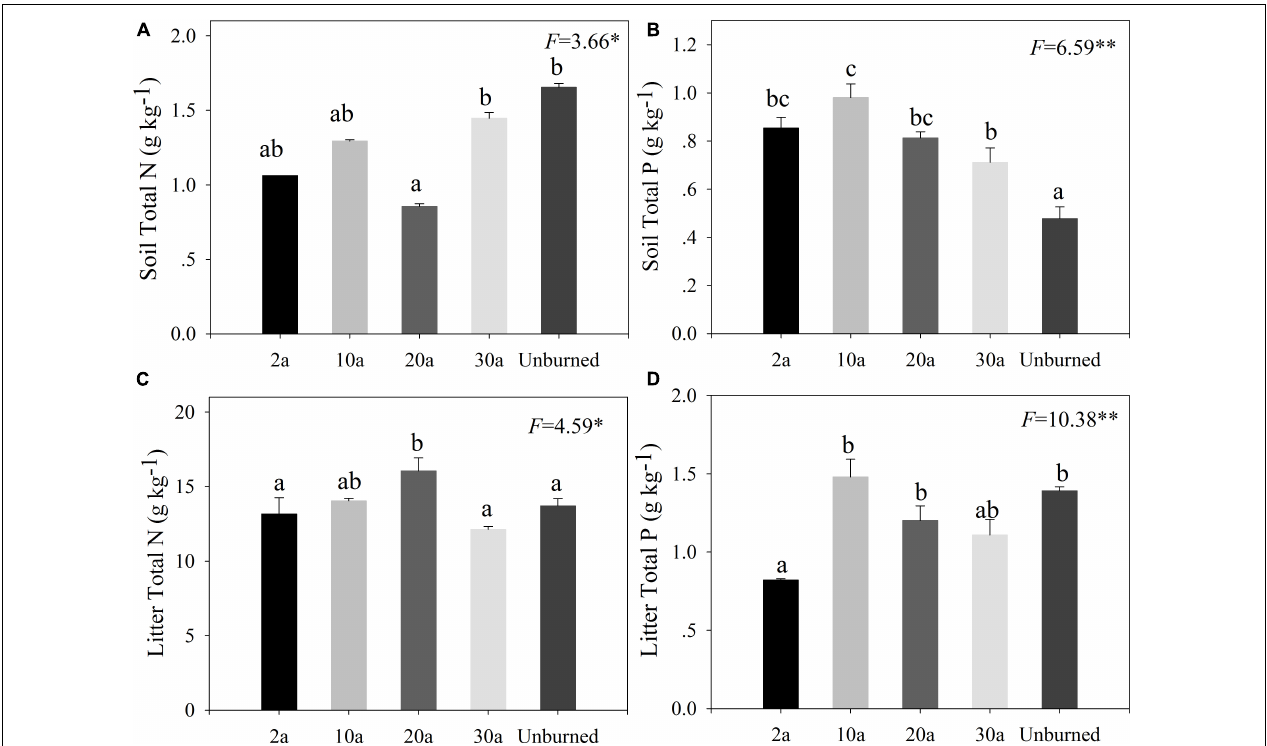
FIGURE 2 | Changes of soil and litter N and P concentrations in different recovery periods. Error bars are standard errors. Different lowercase letters indicate significant differences among different recovery periods (** P < 0.01; * P < 0.05). 2a, 10a, 20a, and 30a are at year 2, year 10, year 20, and year 30 after recovery, respectively. The number of the data involved in analysis of variance (ANOVA) in each recovery period was as follows: soil n = 9 and litter: n = 15. (A,B) The pattern of soil. (C,D) The pattern of